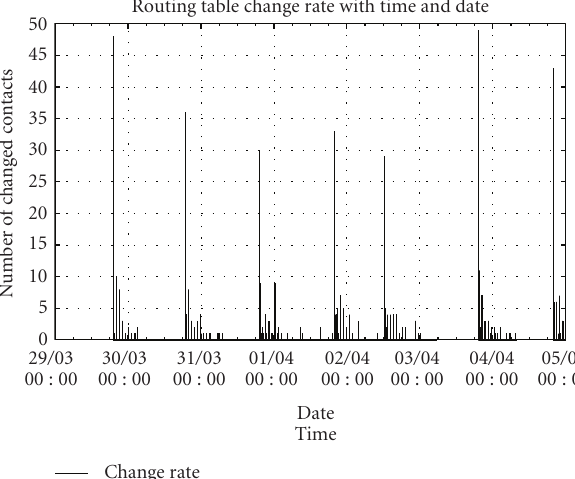
Figure 3: The changing rate of routing